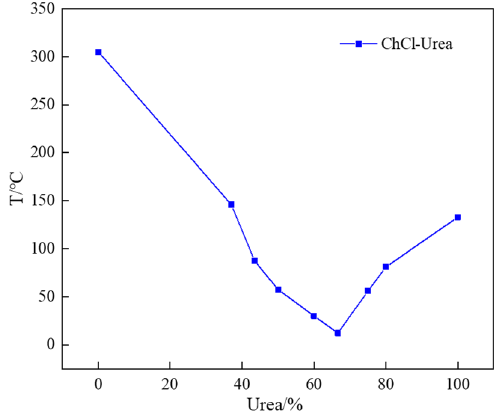
Figure 4. Melting point of ChCl ‐ urea mixture.